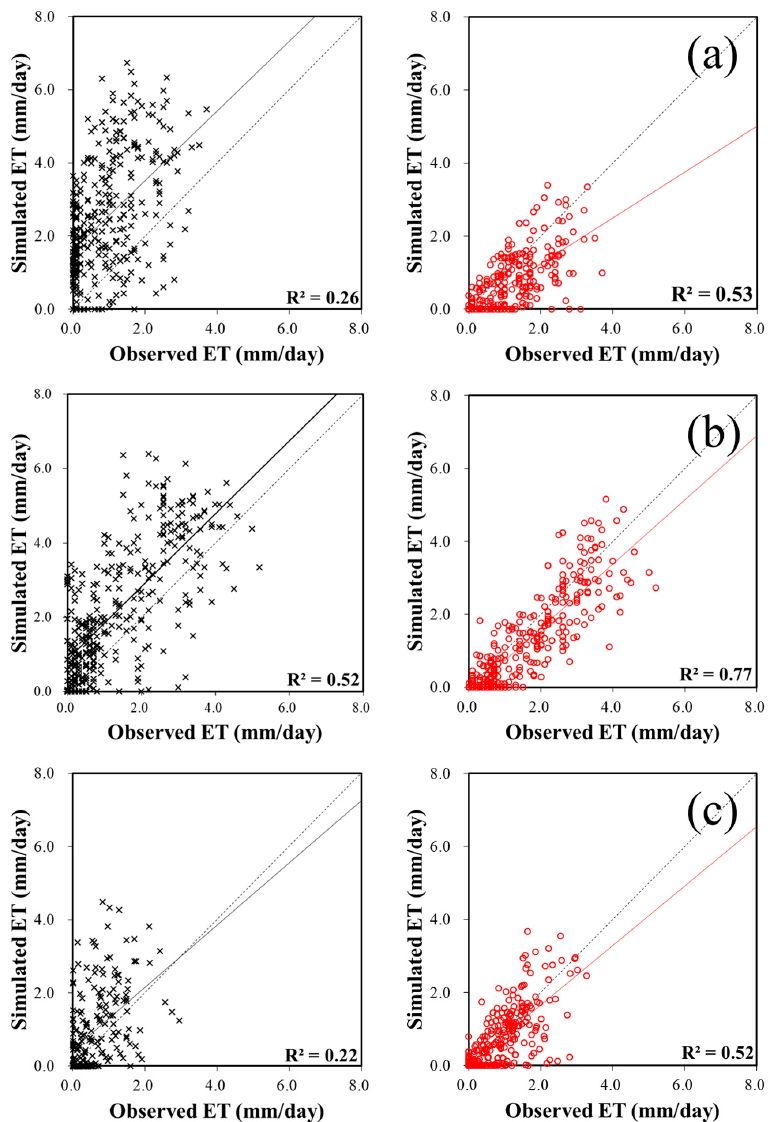
Figure 6. Scatter plots (January to December 2012) of SEBAL simulation ET using extraterrestrial radiation ( left ) and solar radiation ( right ) with flux towers at: ( a ) SMK; ( b ) CFK; and ( c ) DMK. Table 2 shows the statistical summary of the SEBAL model results. The ET from (cid:1844)(cid:1853) (cid:2870)(cid:2872) data indicates that the results were unsatisfactory based on the efficiency criteria. The R 2 between the flux tower and the ET of (cid:1844)(cid:1853) (cid:2870)(cid:2872) data during 2012 was 0.26, 0.52, and 0.22 at SMK, CFK, and DMK, respectively. The other statistical results consisted of NSE s of − 4.91 (SMK), − 0.34 (CFK), and − 1.54 (DMK); IOA s of 0.48 (SMK), 0.77 (CFK), and 0.58 (DMK); and RMSE s of 2.10 mm/day (SMK), 1.46 mm/day (CFK), and 1.03 (DMK). In contrast, the ET from (cid:1844)(cid:1871) data exhibited a reasonably good fit between the flux tower and simulated ET. The R 2 value was 0.53, 0.77, and 0.53 at SMK, CFK, and DMK, respectively. The other statistical results consisted of NSE s of 0.41 (SMK), 0.67 (CFK), and 0.41 (DMK); IOA s of 0.82 (SMK), 0.92 (CFK), and 0.84 (DMK); and RMSE s of 0.67 mm/day (SMK), 0.73 mm/day (CFK), and 0.53 (DMK). Both the ET using (cid:1844)(cid:1853) (cid:2870)(cid:2872) data and (cid:1844)(cid:1871) data indicated that the CFK site produced the most reasonable results.